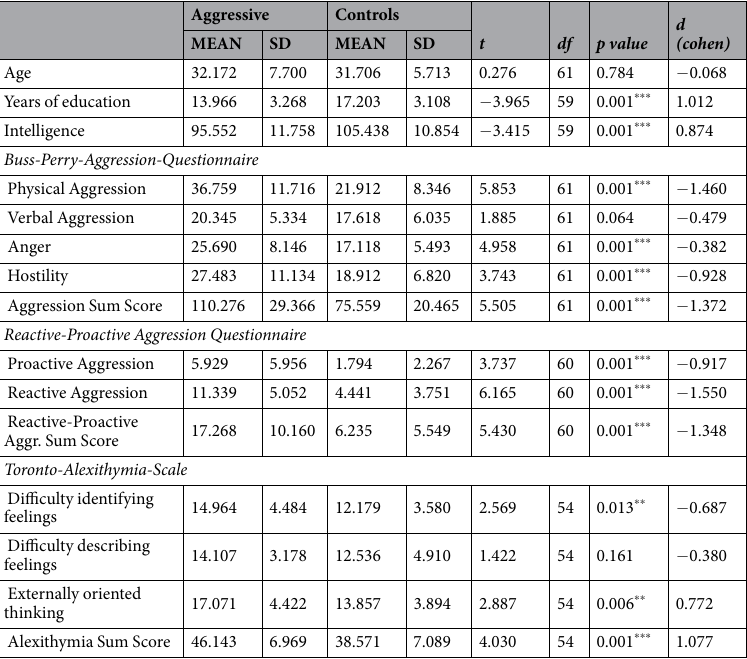
Table 1. Characteristics of men with a history of aggressive behaviour and controls, Buss-Perry-Aggression- Questionnaire (BPAQ), Reactive-Proactive Aggression Questionnaire (RPQ) and (Toronto-Alexithymia- Scale-26). Note: * Indicates statistical significant p-value: * p ≤ 0.05, ** p ≤ 0.01, *** p ≤